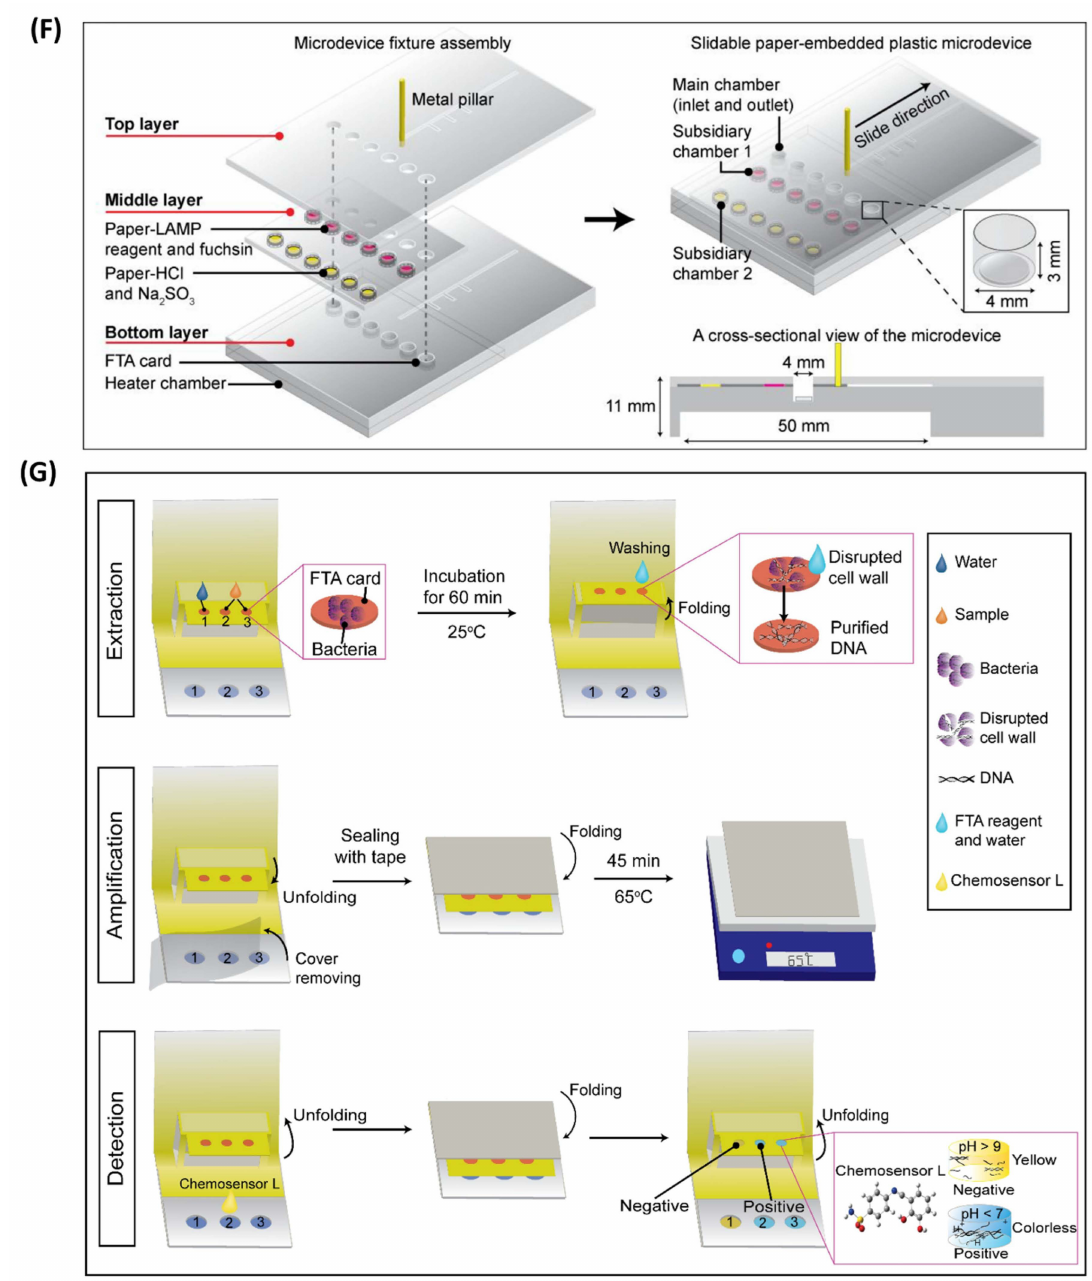
Figure 7. LAMP-on-a-chip biosensors. ( A ) Schematic workflow of graphene-heater-integrated polycarbonate-based foldable microdevice. ( B ) Structural overview of a rotary valve-assisted fluidic chip. ( C ) Centrifugal microfluidic disc for multiplex RT-LAMP. ( D ) Schematic workflow of colori- metric detection of LAMP amplicons on a wax-printed paper microdevice. ( E ) Working principle of paper-based microdevice with a spinning mechanism. ( F ) Structural overview of FTA card-based fully integrated slidable paper microdevice. ( G ) Illustration of a pop-up, paper-based, fully integrated microfluidic platform. Reproduced with permission from references [121,124,130,133,138,145,146]. Copyright 2017, 2019, 2021 American Chemical Society; and 2019, 2021, and 2022